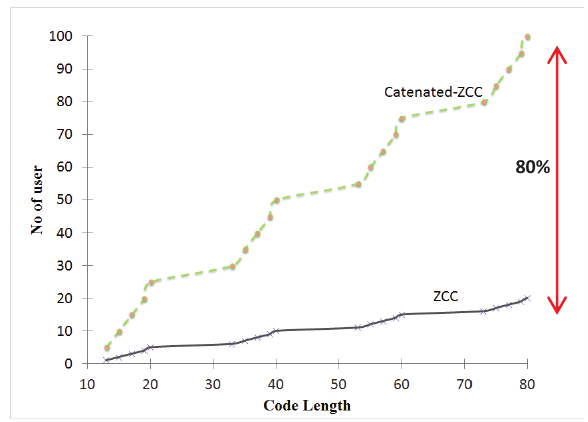
Fig. 4. Comparison of code length for catenated- OFDM/OCDMA-ZCC with conventional OCDMA-ZCC